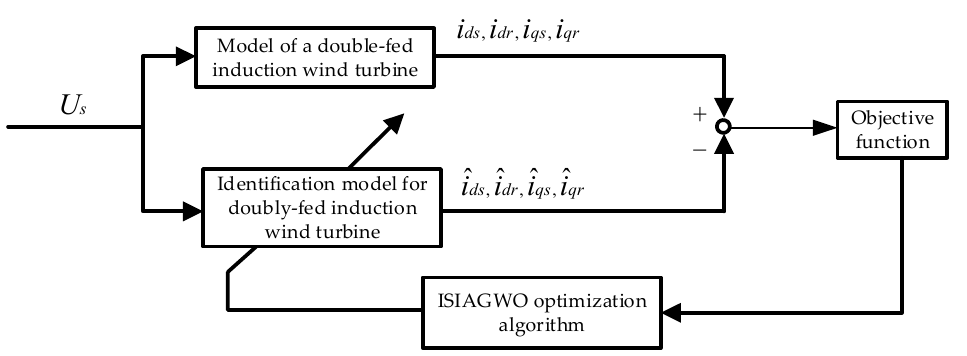
Figure 10. Principle of DFIG parameter identification. The ISIAGWO algorithm was used to identify the DFIG parameters, and the flow chart is shown in Figure 11 below.